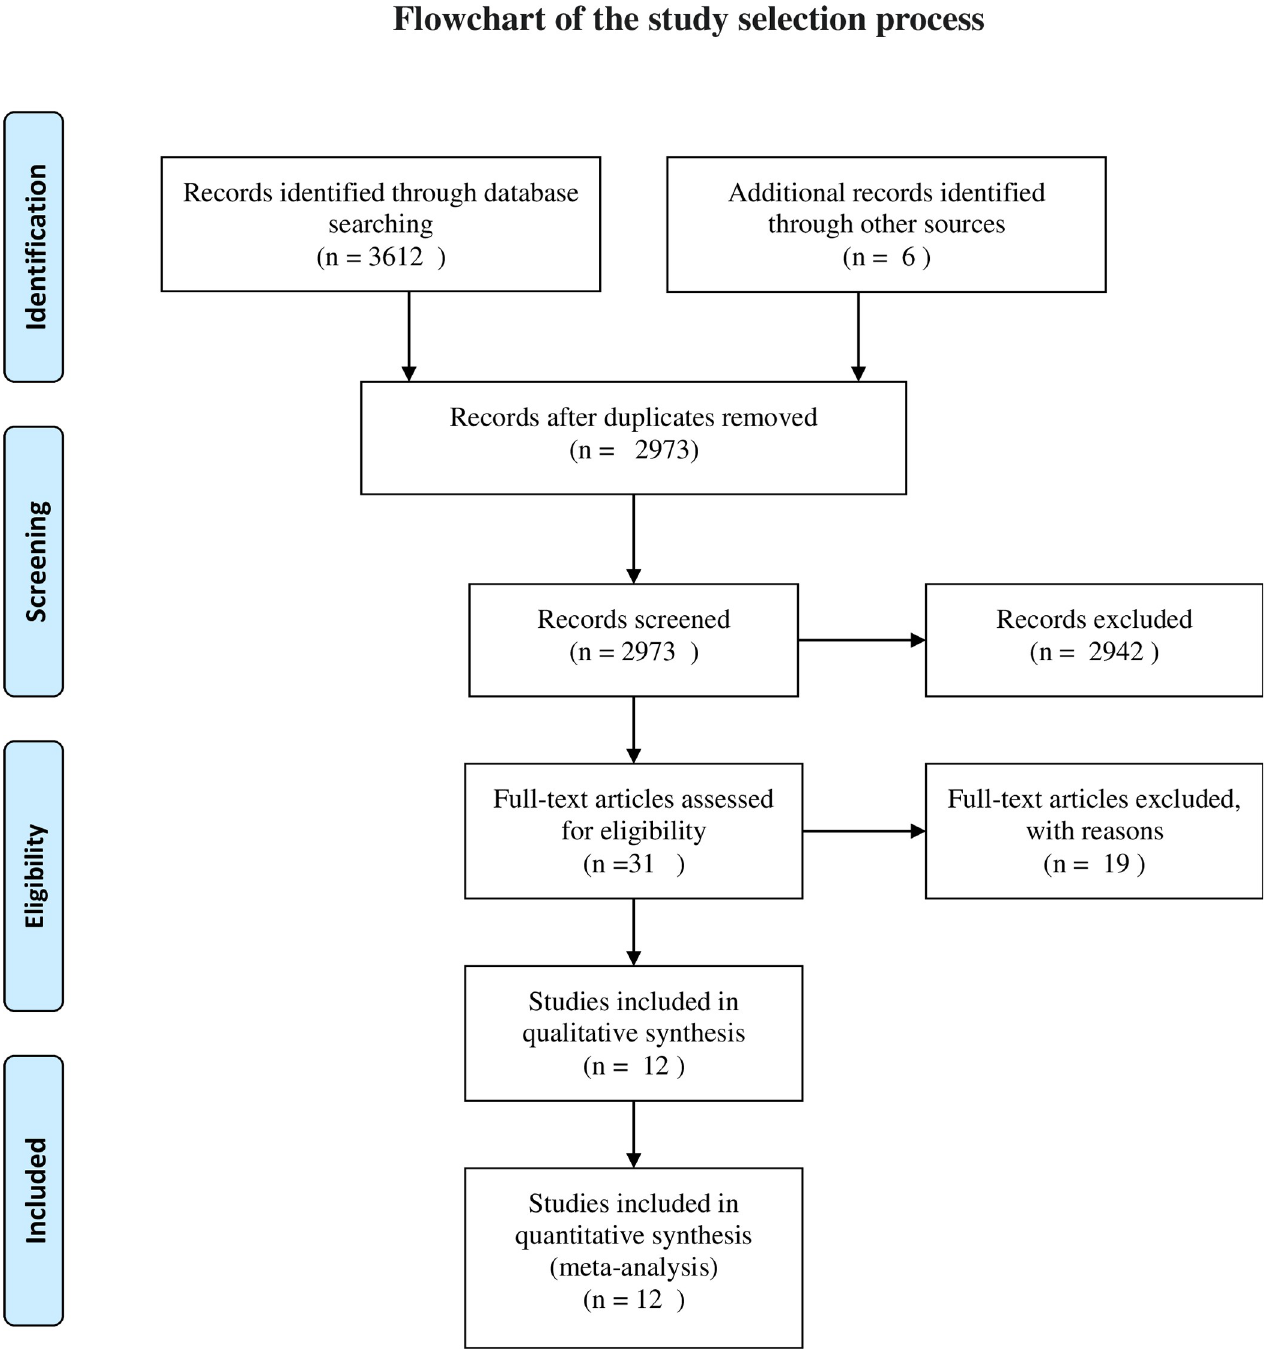
Fig 1. Study flow